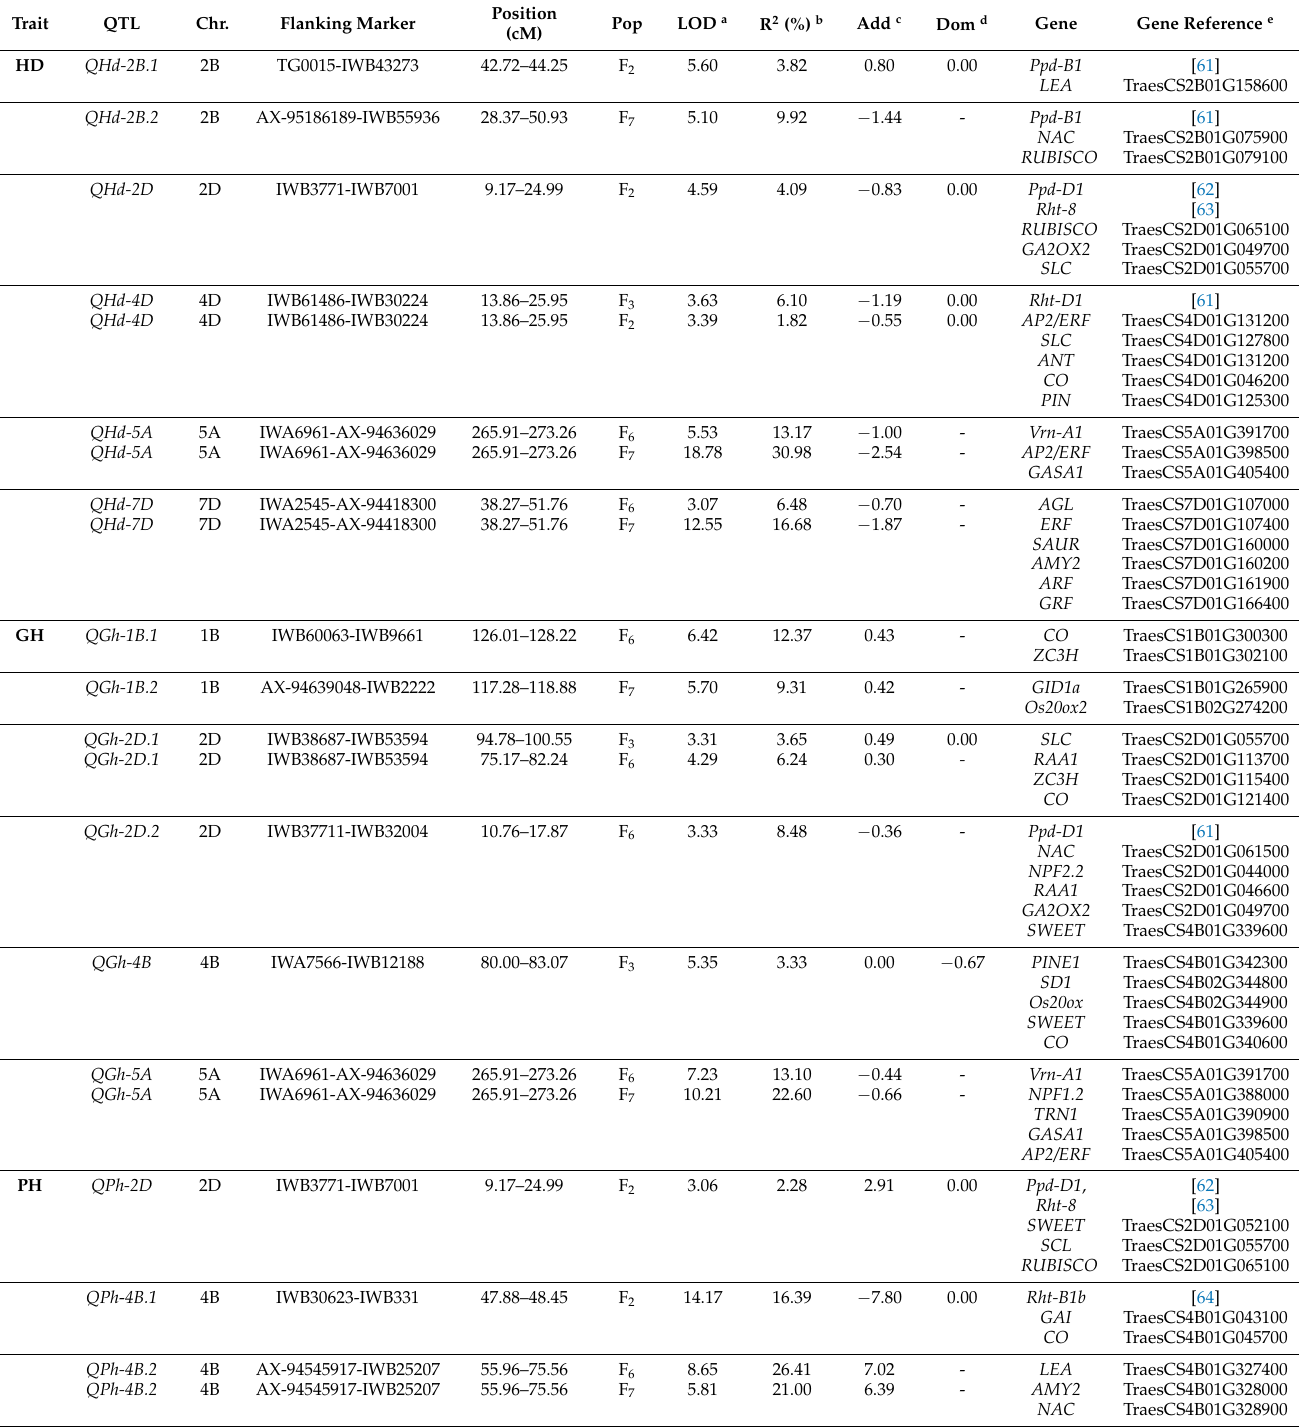
Table 2. QTLs significantly associated with the five morpho-physiological traits in the mapping populations. HD, heading date; PH, plant height; GH, juvenile growth habit; TTN, total tiller number; FTN, fertile tiller number; pop, population; chr.,